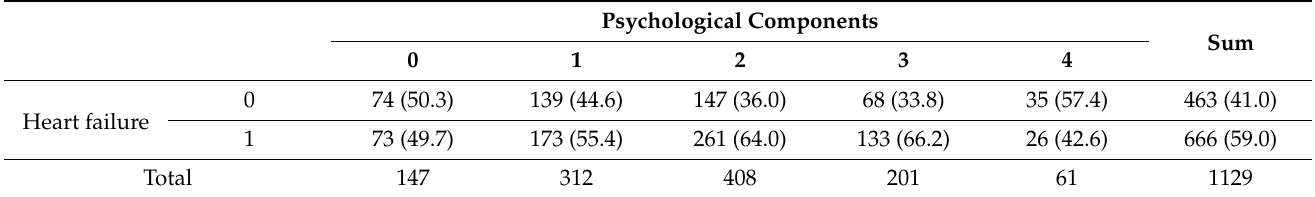
Table 5. Distribution of subjects by aggregate psychological component index value and heart failure occurrence. Numbers in parentheses denote column-wise percentages.